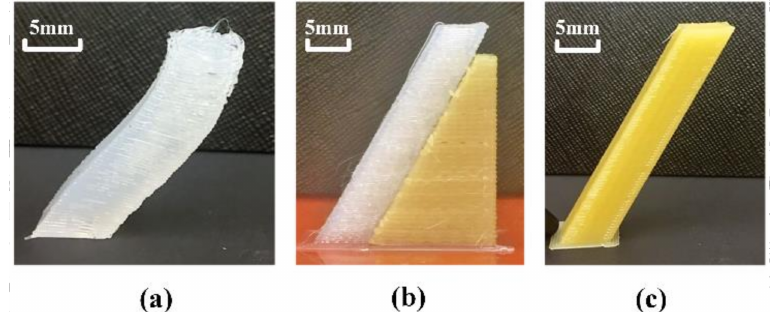
Figure 7. Printed samples with 60 o overhang angle and 30 mm height ( a ) silicone sample printed without using the support structure, ( b ) silicone printed with the support structure, and ( c ) PVA sample printed without the support structure.